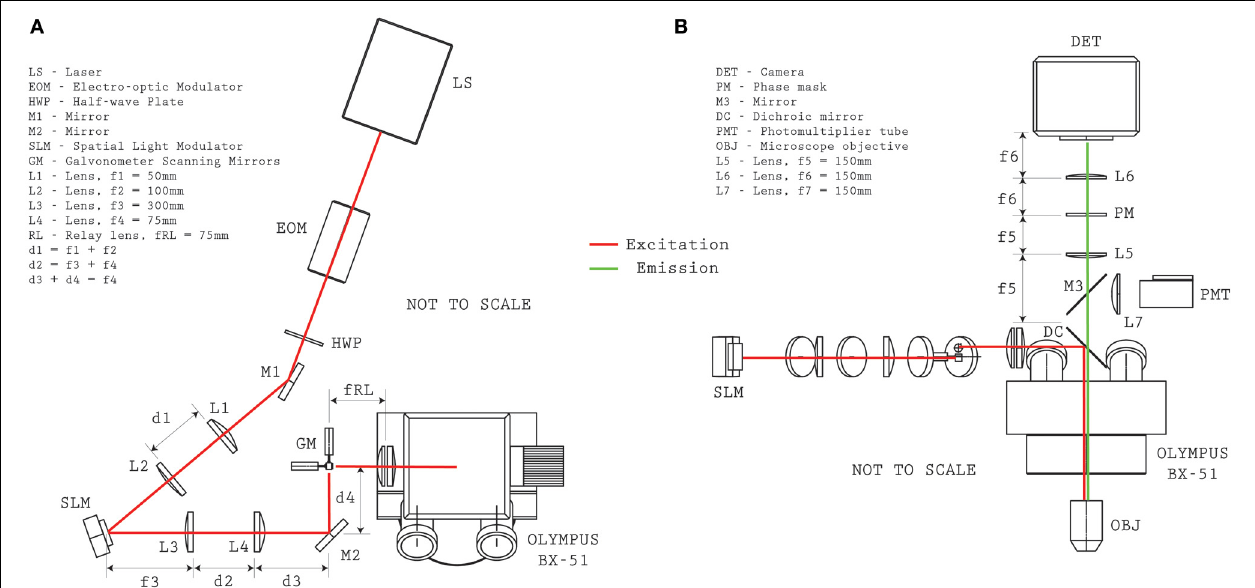
FIGURE 2 | Optical system configuration. Plan (A) and elevation (B) views provide the relative distances between optical elements for reproducing the microscope configuration.